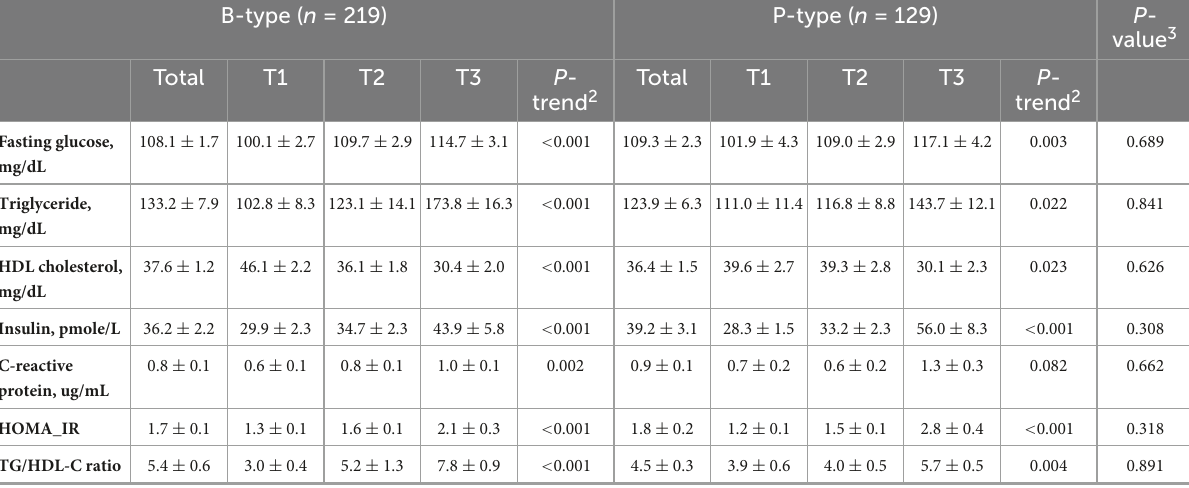
TABLE 3 The concentration of plasma biomarkers across tertiles of dietary pattern scores by enterotypes 1 . B-type ( n =